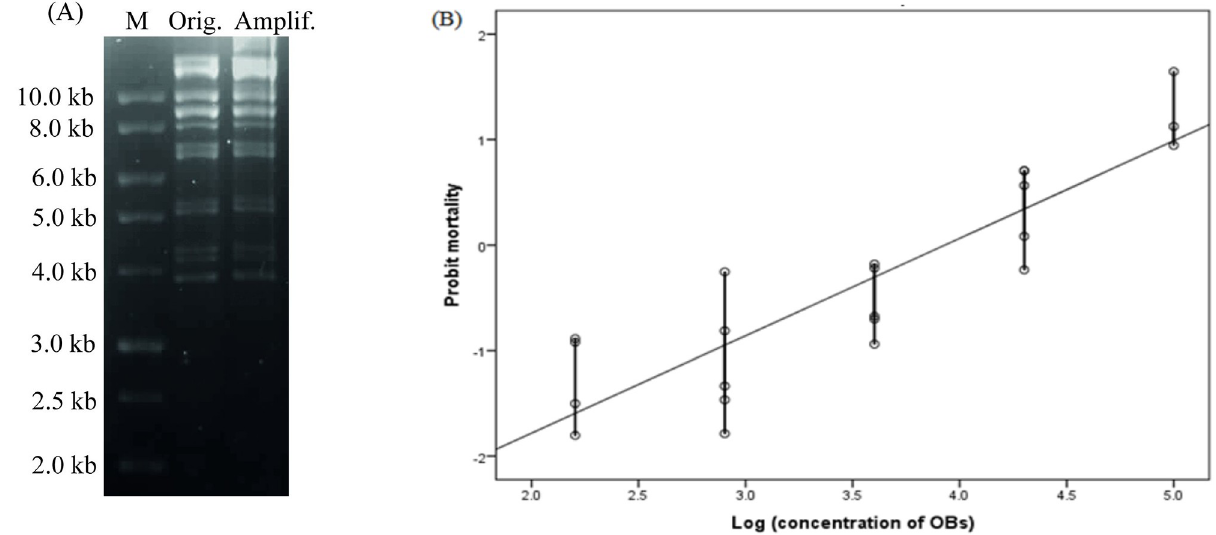
Fig 1. Restriction endonuclease analysis ( Bgl II) of ChchSNPV-TF1 and probit regression line. (A) Restriction endonuclease analysis ( Bgl II) following digestion of genomic DNA of the original inoculum (Orig.) and the laboratory-amplified (Amplif.) OBs of ChchSNPV-TF1. The DNA 1 kbMarker Ladder (Nippon, Tokyo, Japan) was used as a molecular size marker (M). (B) Probit regression line obtained after laboratory production was determined by bioassay in 2 nd -instar Chrysodeixis chalcites larvae (y = 0.92x—3.63, R 2 = 0.78).